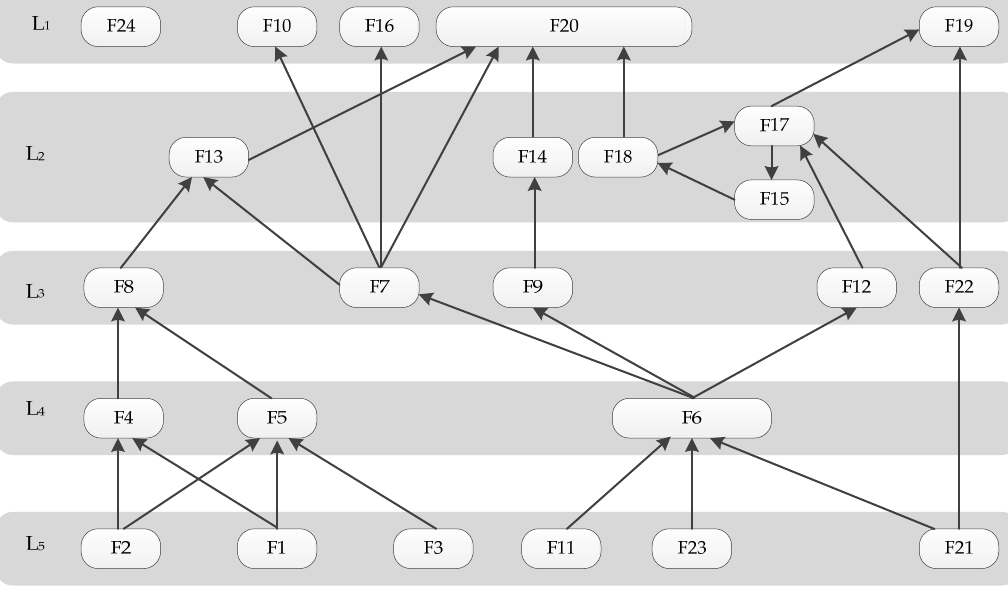
Figure 4. Interpretative structural model.